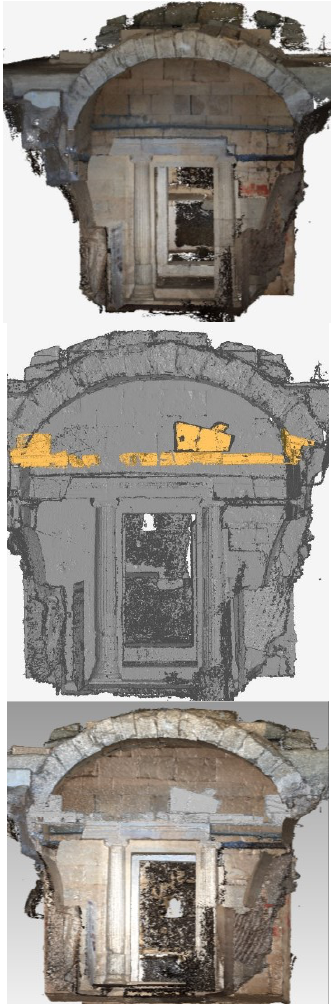
Figure 13: The virtual restoration of the Macedonian tomb of Macridy